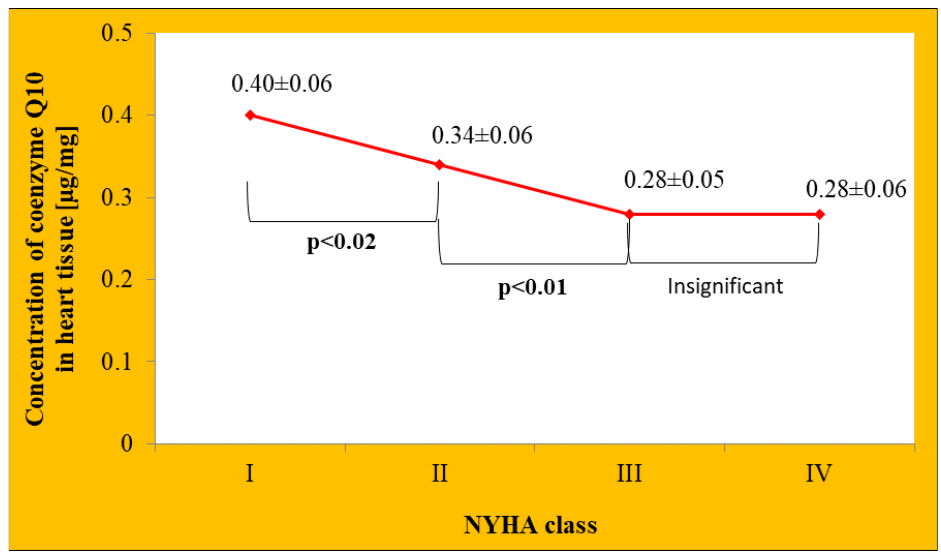
Figure 5. Changes in the concentration of coenzyme Q10 in the heart tissue depending on the sever- ity of heart failure according to the NYHA scale. Based on information from [26].